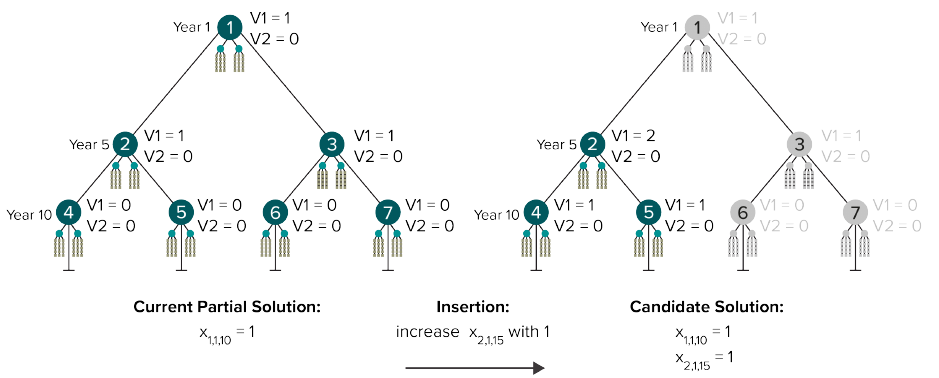
Figure 2. Candidate insertion into a current partial